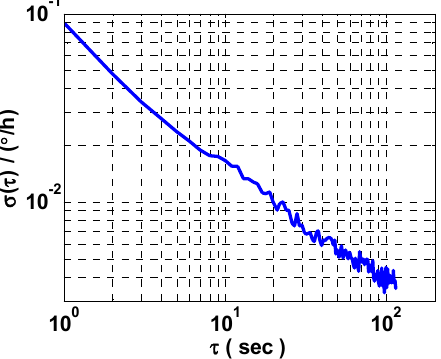
Figure 4. AVAR results of the resultant gyro noise difference data of x and z mechanically dithered RLGs under stationary condition.